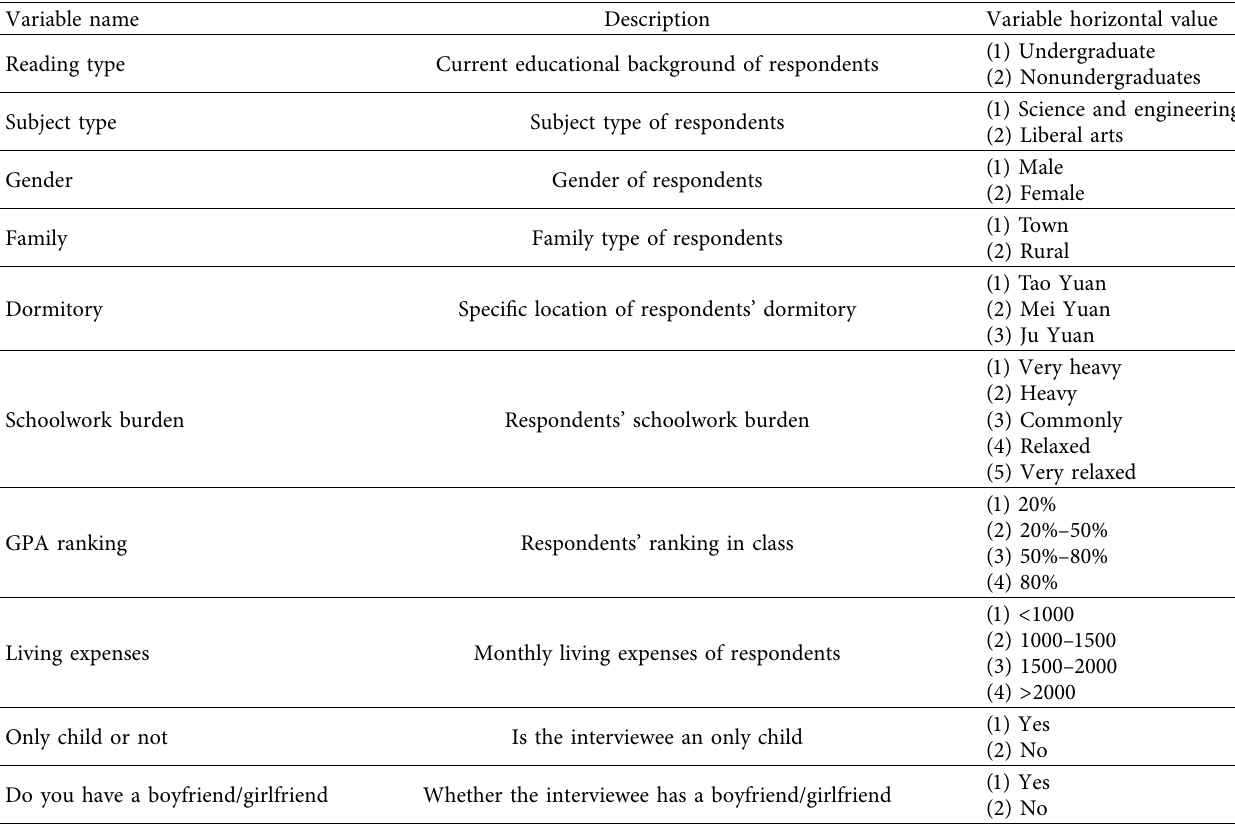
Table 1: A survey of personal social